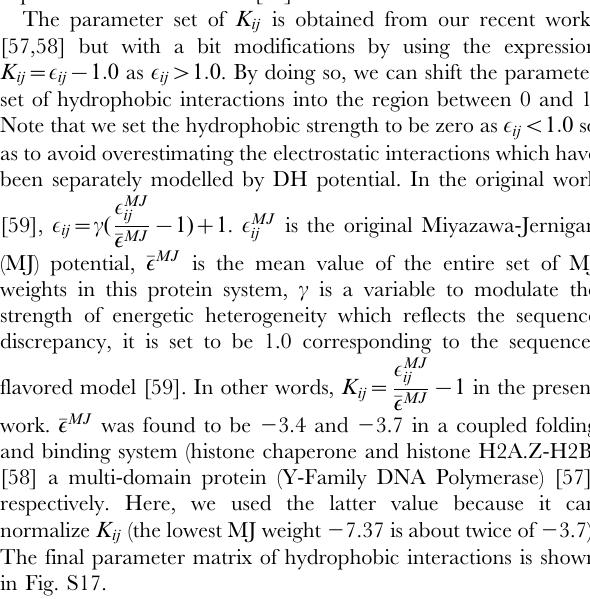
forces, thus represents a ‘‘wrong’’ structure. The free energy surface clearly indicates that the free Ub model doesn’t sample such conformation. In contrast, the free Ub model can sample most of the ‘‘right’’ compact conformations. This indicates that the assembly of free Ub monomers into similar functional states of diUbs is far beyond random events. (PDF) Figure S3 Interfacial contact maps of the free Ub model and the eight linkage models. (A) Free Ub monomers. (B) K11-diUb. (C) K27-diUb. (D) K29-diUb. (E) K33-diUb. (F) K48- diUb. (G) K63-diUb. (H) Linear diUb. (PDF) Figure S4 Estimation of entropic and enthalpic contri- butions of a bonded constraint by the formula I 3 m 4 p { ln ( p ( m , b )) . p ( u , b ) ~ ( ) 3 2 ( ) 3 is the average probability b 4 p N 3 to form a bond/contact constraint with m contacts/bonds already present, where N is the residue number, b is the persistent length of a peptide chain, and I is the length of the bonded constraint. For our diUb models, N= 152 and I= 4.0 A˚ . (PDF) Figure S5 Entropy-enthalpy compensation analysis by decomposing free energy F(x) into v E I w (x) and TS(x). Here x is R I 36 I 36 . (PDF) Figure S6 Entropy-enthalpy compensation analysis by decomposing free energy F(x) into v E I w (x) and TS(x). Here x is R COM . (PDF) Figure S7 Entropy-enthalpy compensation analysis by decomposing free energy F(x) into v E I w (x) and TS(x). Here x is R I 44 I 44 . (PDF) Figure S8 Hydrophobic interactions E HP and electro- static interactions E elec at the interface between Ub units. The results are from the simulations by the free model. (A) Free energy profile as a function of R COM and interfacial E HP . (B) Free energy profile as a function of R COM and interfacial E elec . (C) Free energy profile as a function of interfacial E HP and interfacial E elec . E HP is negatively related to E elec . (D) Distribution of E HP and E elec as a function of the distance between I44 hydrophobic patches of two Ub monomers ( R I 44 I 44 ). Green color represents the electrostatic interaction distribution and red color represents the hydrophobic interac- tion distribution. Figure S9 Criteria for determining the open, closed and compact states are defined according to the correspond- ing free energy profiles. It shows the free energy profiles as a function of R I 36 I 36 , R I 36 I 44 and R I 44 I 44 , as an example. The peak value of the transition state region was used as the cutoff distance to define these states. Thus, 0.96 nm, 0.93 ns and 0.86 nm are used to define the I36I36, I36I44 and I44I44 substates, respectively. Figure S10 Three intermediate states revealed on the free energy surface of K48-diUb. (PDF) Figure S11 The free energy surfaces between K63-diUb and linear diUb are highly similar to each other